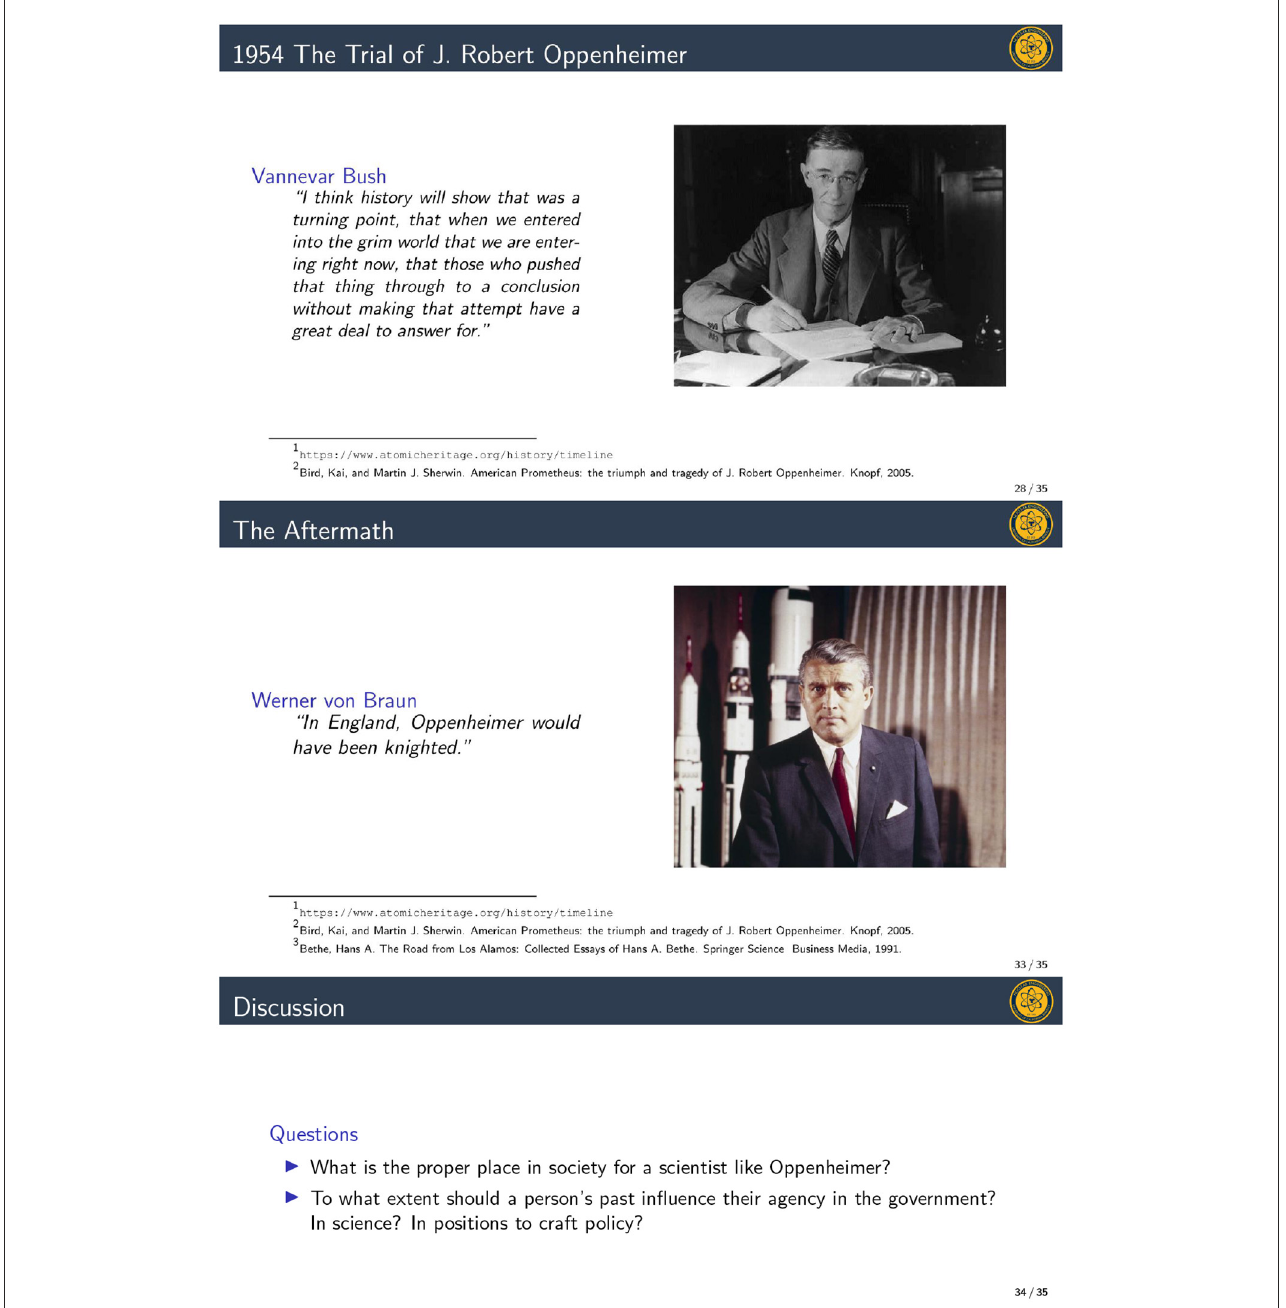
FIGURE16 Slides outlining the public and scientific response to the trial of Robert Oppenheimer.